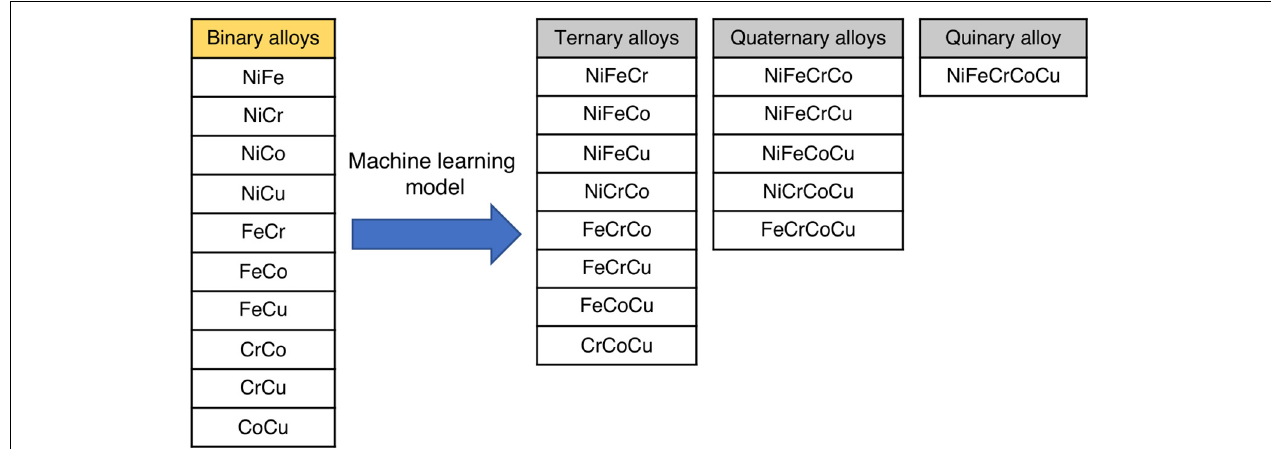
FIGURE 5 | Schematic representation of ten binary alloys used to predict the vacancy migration and formation energies of eight ternary, five quaternary and one quinary alloy systems using ML framework.